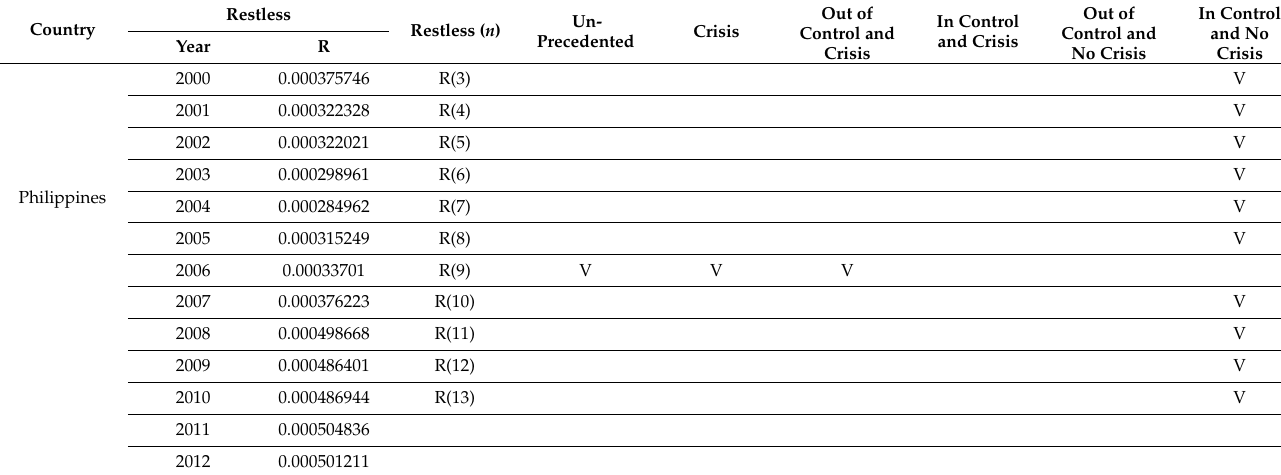
Table 2. Restlessness in the